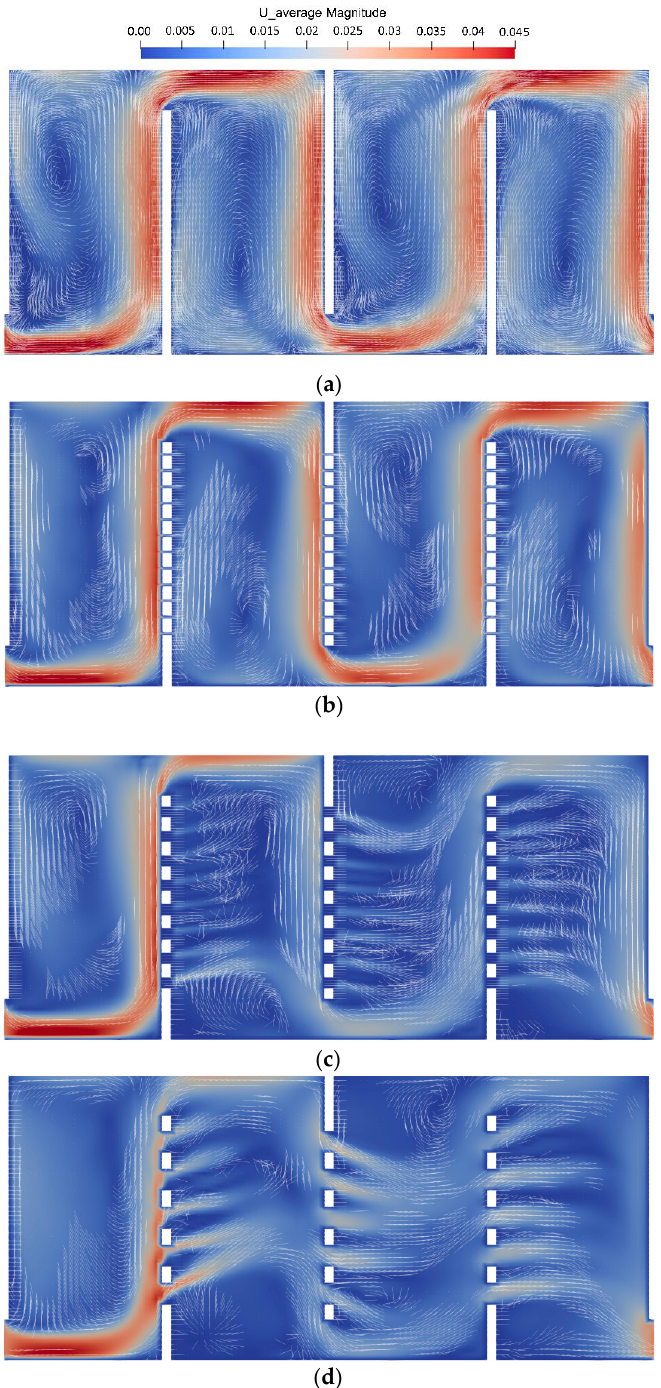
Figure 4. Time-averaged absolute velocity vectors in the center-plane (z/L = 0.5) of ( a ) conventional reactor and ( b ) D2, ( c ) D8 and ( d ) D16 perforated designs.